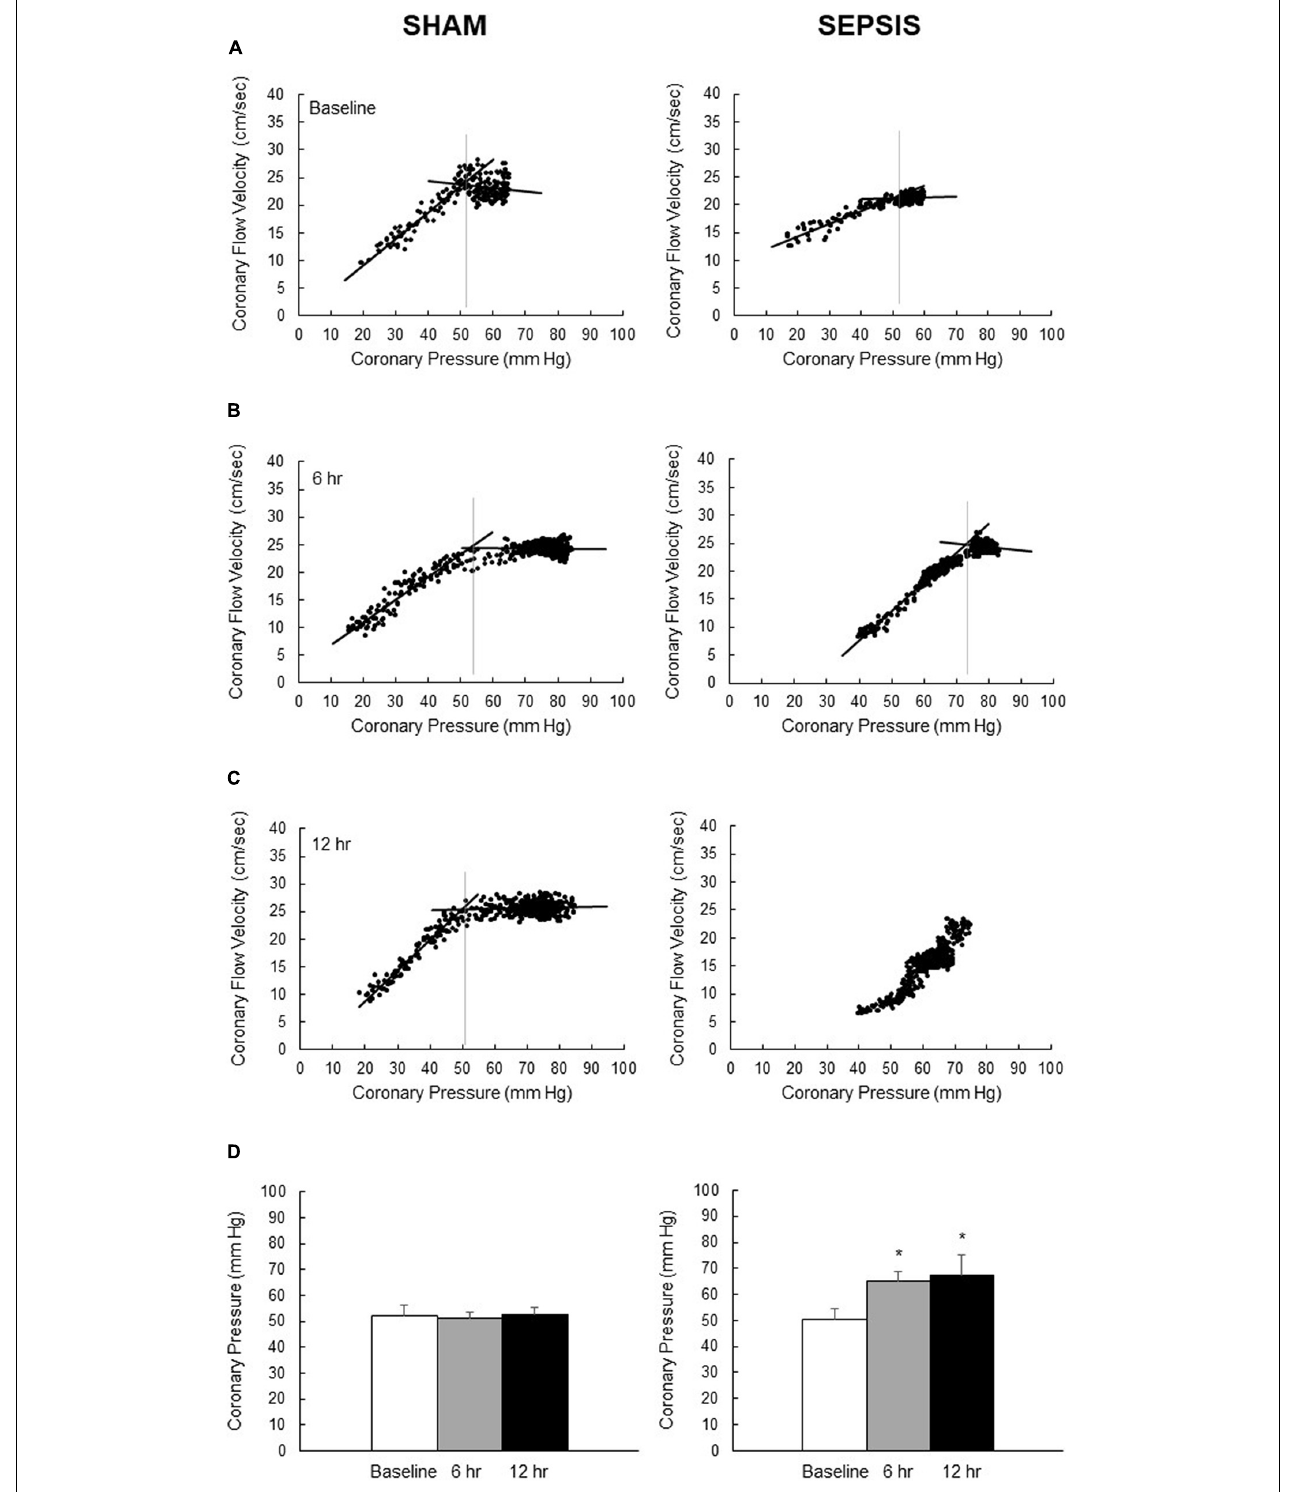
FIGURE 1 | Coronary pressure–flow velocities relationship for the determination of autoregulatory breakpoint pressure. Representative pictures of overtime evolution, beat par beat, of pressure–flow datapoints (black dots) following inflation of the intracoronary balloon to determine the autoregulatory plateau and the ischemic pressure–flow relationship (black lines) and its autoregulatory breakpoint (vertical gray lines) for one representative animal from the sham group (left panel) and